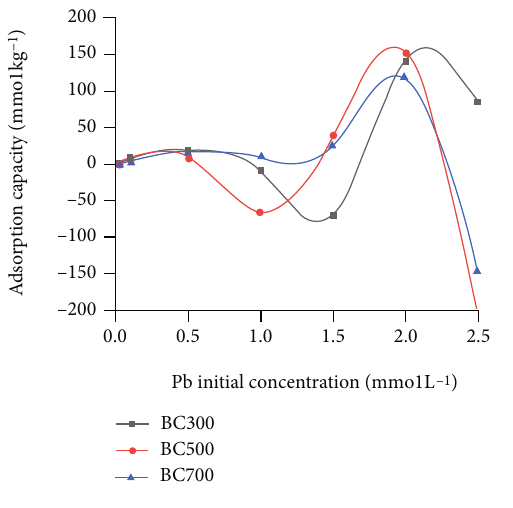
Figure 5: Adsorption of Cd 2+ in straw with di ff erent concentrations of heavy metal ions.